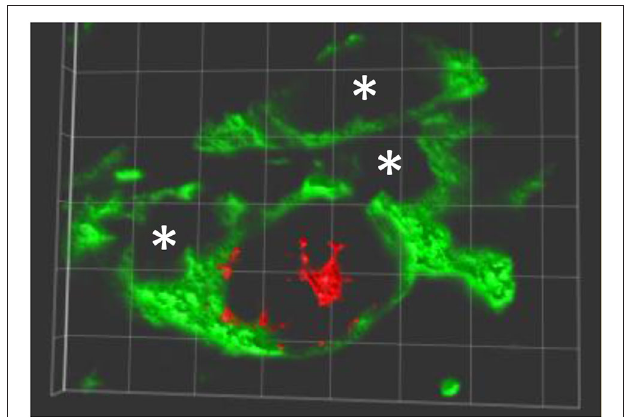
FIGURE 1 | New TH expressing neurons in SNpc of allopreganolone treated mice lesioned by MPTP . A 3-dimensionally rotated double-immunolabeling image shows a new neuron (red, BrdU positive in nuclear) expressing TH (green in cytoplasm and neurites), and a few TH positive only neurons marked with *. Similar image can be found in Adeosun et al. (2012).